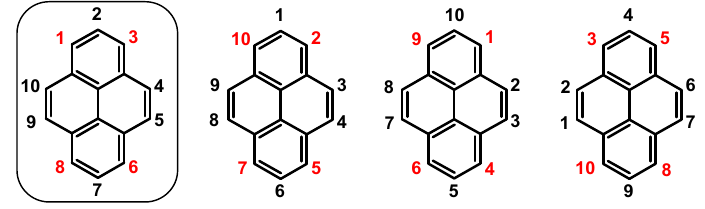
Figure 1. Various locant numeration for pyrene structure.